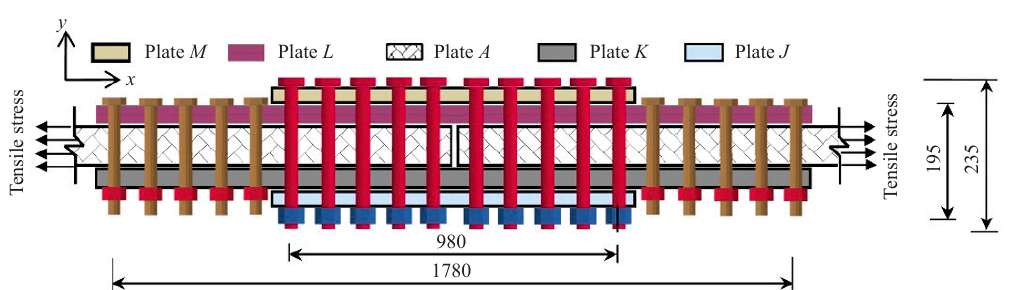
Figure 7. The details of bolt connection for plate